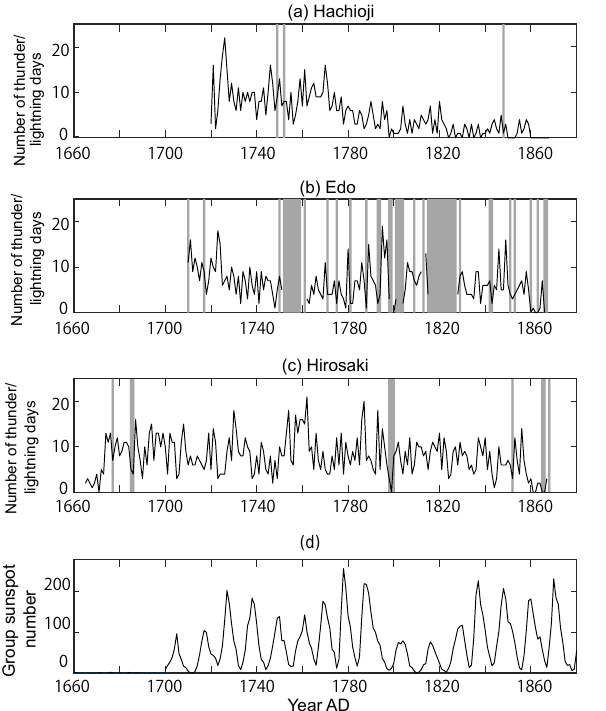
Figure 1. Time series of the number of thunder/lightning days from May to September extracted from old diaries in (a) Hachioji, (b) Edo, and (c) Hirosaki and the time series of (d) the group sunspot numbers (GSNs) for the periods of AD 1650–1700 (Hoyt and Schat- ten, 1998) and AD 1700–1900 (Clette and Lefevre, 2016). The gray highlights in (a–c) indicate the years when there were interruptions of the recordings for ≥ 30